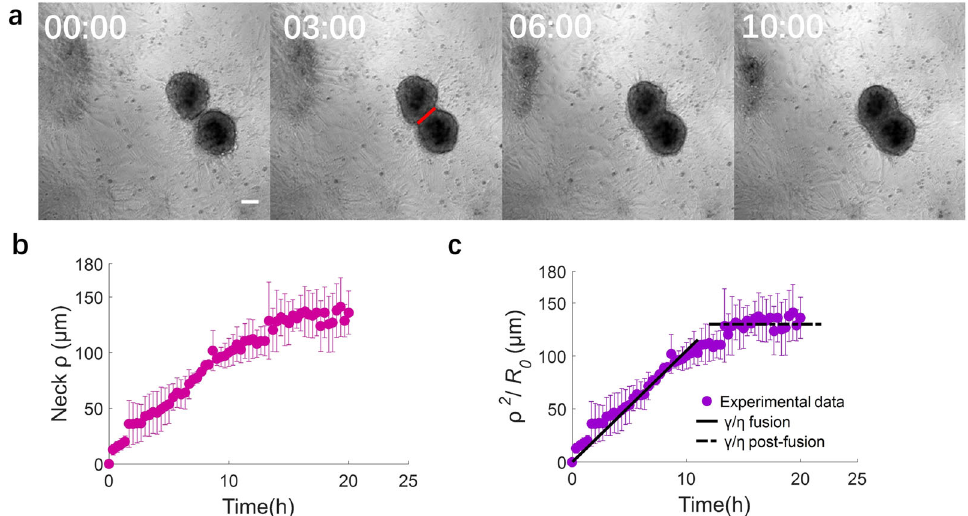
Fig. 4 Cluster fusion. a Phase contrast images of two fusing SMC clusters at different times. Times are in hours. Red line: 2 ρ , where ρ is the “ neck ” radius. Scale bar: 100 μ m. b Time evolution of “ neck ” radius ρ for the fusion of pairs of clusters having approximately the same size (diameter ~200 μ m). c Time evolution of the normalized neck radius. During fusion, γ / η = 2.9 × 10 − 9 m/s. The “ neck ” radius stabilizes at the value of the cluster radius (~130 μ m). Equation for γ / η is indicated in the text. Panels b and c: mean ± SD, N =